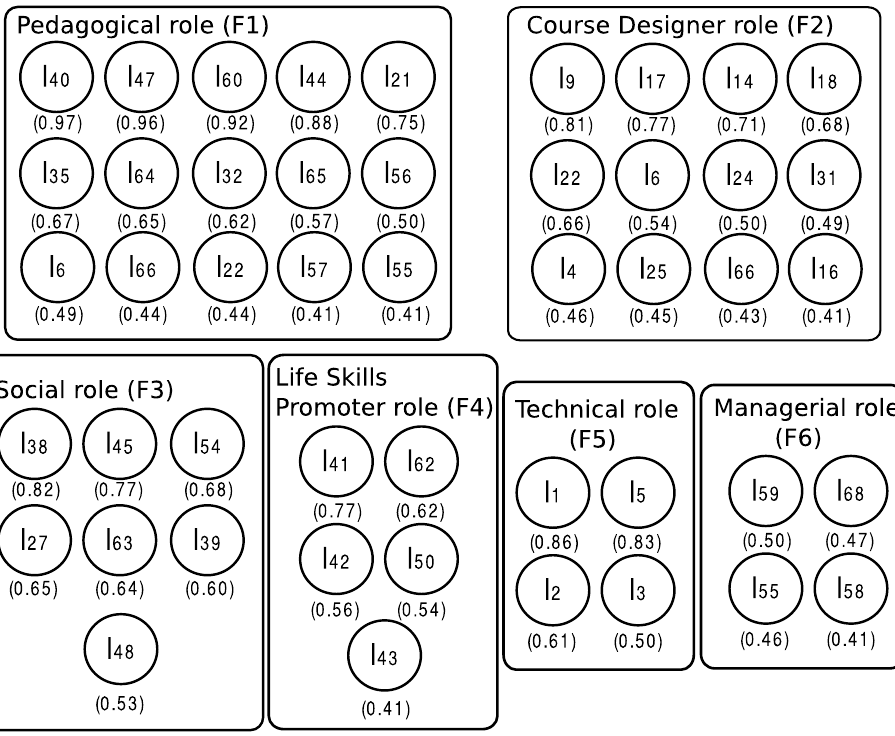
Figure 2. Diagram representing the factor structure of the final 43-item educational role-based model. The pedagogical role includes the 28% of the total variance, course designer 18%, social 10%, life skills promoter 8%, technical 6%, and managerial